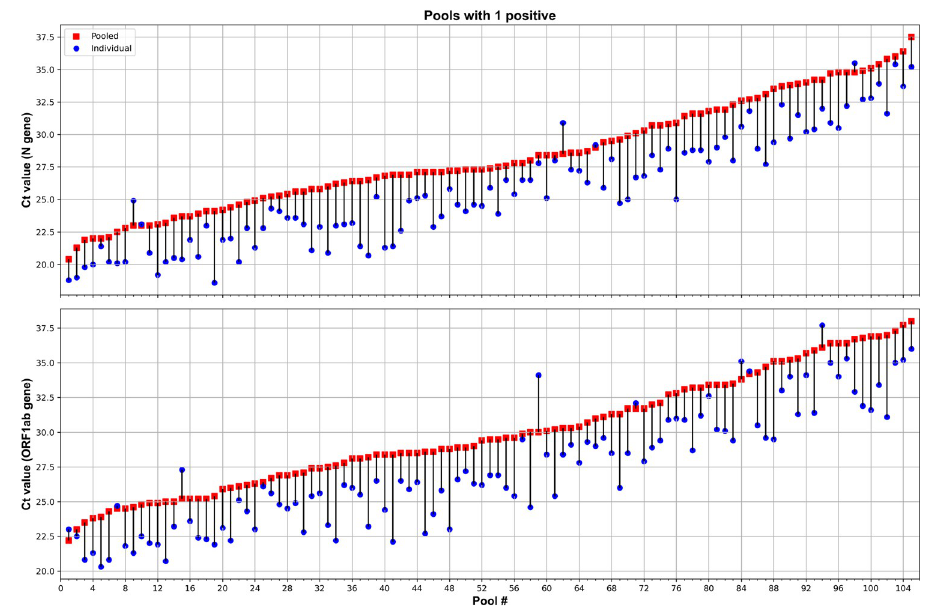
Fig 1. Pools with a single positive. Scatter plots showing cycle threshold (Ct) values and Ct shifts detected by rRT-PCR in five-samples pools (squares), composed of four negative and one positive sample, with respect to the individual positive samples (circles) for N (top graph) and ORF1ab (bottom graph) genes. https://doi.org/10.1371/journal.pone.0266408.g001 positive sample (inconclusive result according to the criteria provided in the user manual of the rRT-PCR kit, so a new sample was requested). Analysis of the Ct values distribution of the indeterminate group, indicates that there are no significant differences ( P < 0.05) for both, N and ORF1ab genes, regardless of whether any pool contained positive samples ( Fig 4 ).